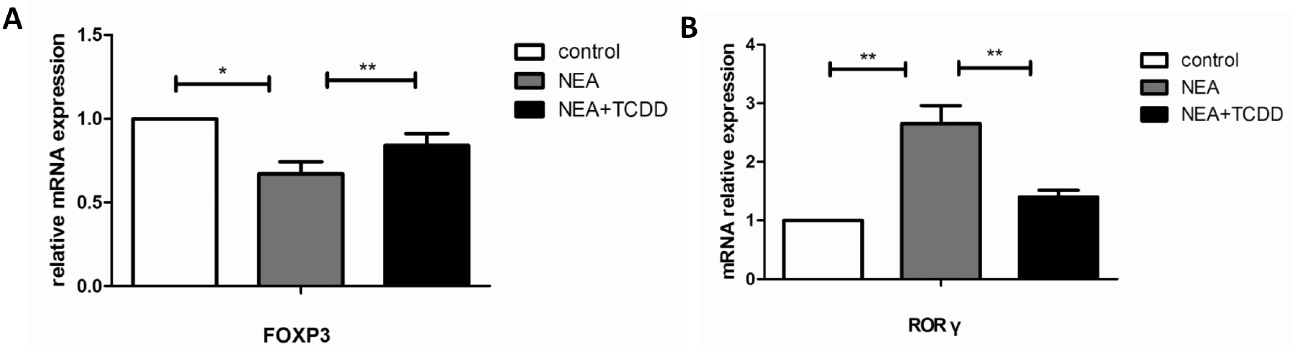
Fig 6. TCDD-induced AhR activation promoted FOXP3 expression and inhibited ROR γ expression. Cells from the spleens were restimulated with leukocyte activation cocktail for 5 hours. (A) mRNA expression of FOXP3 in lymphocytes was determined via real-time PCR. (B) mRNA expression of ROR γ in lymphocytes was determined via real-time PCR. N = 5 per group and * P < 0.05, ** P <